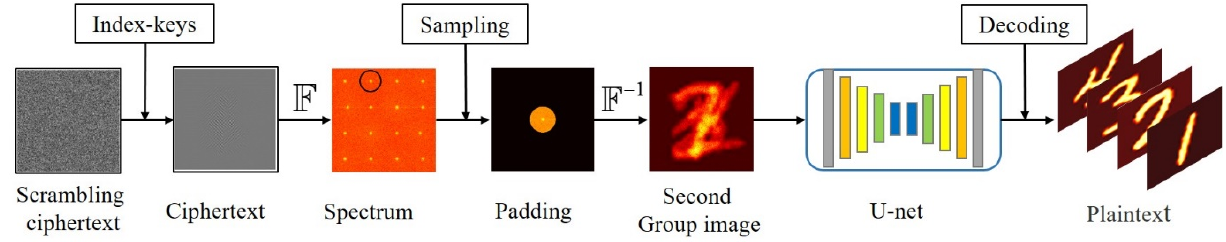
Figure 5. The decryption process.